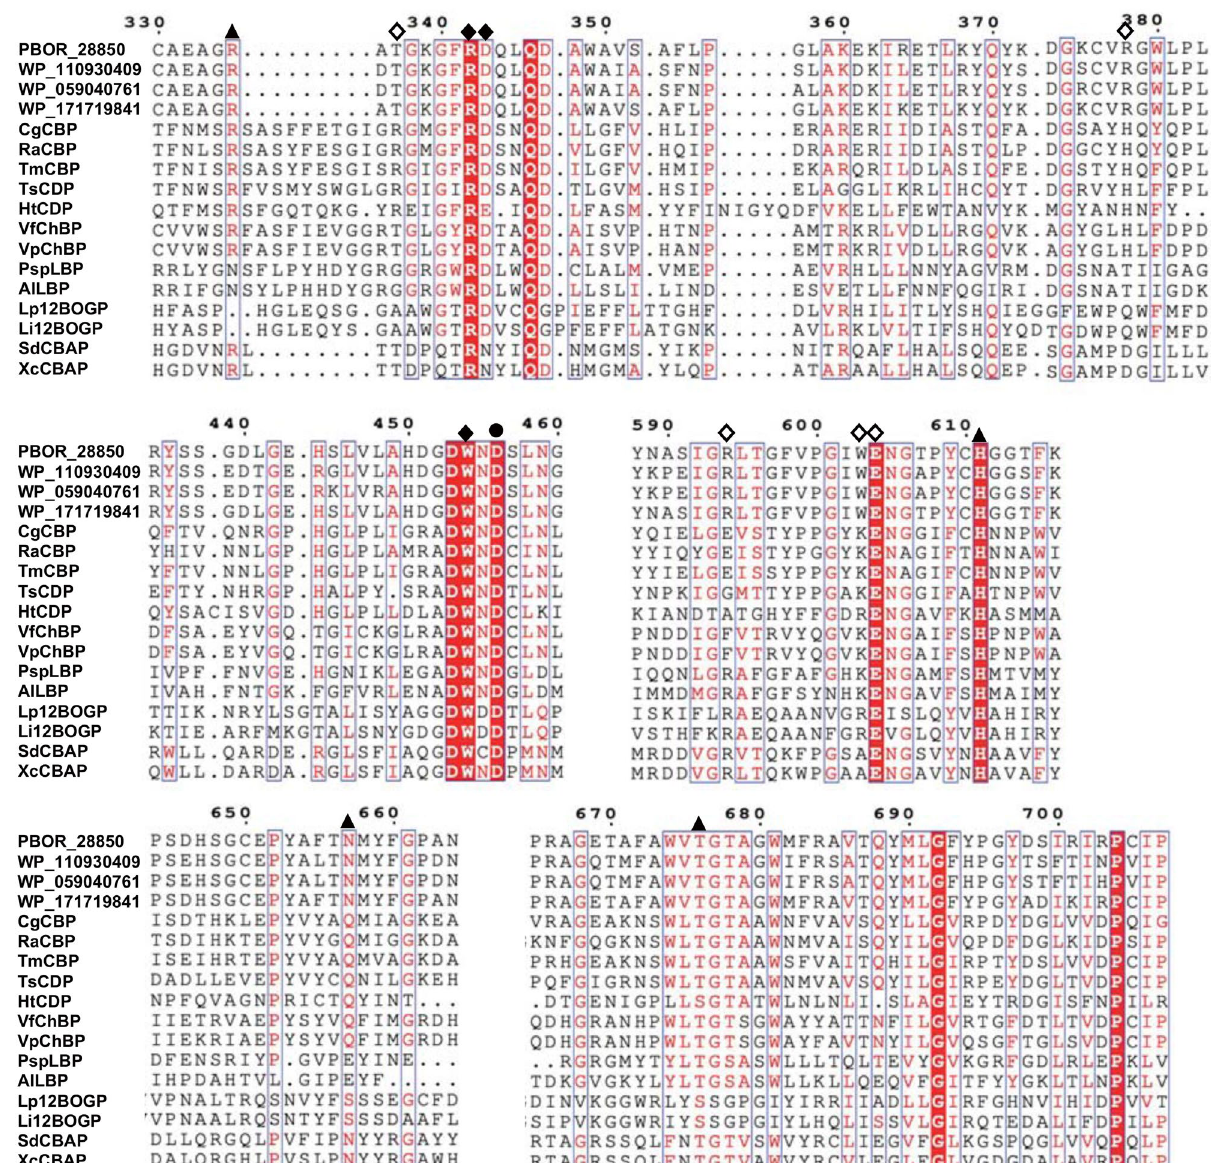
Figure 7. Comparison of amino acid sequences of GH94 enzymes. Multiple sequence alignment was constructed using MAFFT-DASH 31 . Filled circle indicates the general acid catalyst for the phosphorolysis of substrates. The residues shown by filled triangles are responsible for binding to phosphate. Filled and open diamonds indicate residues involved in the formation of subsites −1 and + 1, respectively. Amino acid numbers of PBOR_28850 are shown above the figure. WP_110930409, WP_059040761, and WP_WP_171719841 from P. bouchesdurhonensis , P. rubinfantis , and P. phytohabitans , respectively, are homologues of PBOR_28850. CgCBP, C. gilvus CBP; RaCBP, R. albus CBP; TmCBP, T. maritima CBP; TsCDP, T. stercorarium CDP; HtCDP, H. thermocellum CDP; VfChBP, V. furnissii ChBP; VpChBP, V. proteolyticus ChBP; PspLBP, Paenibacillus sp.